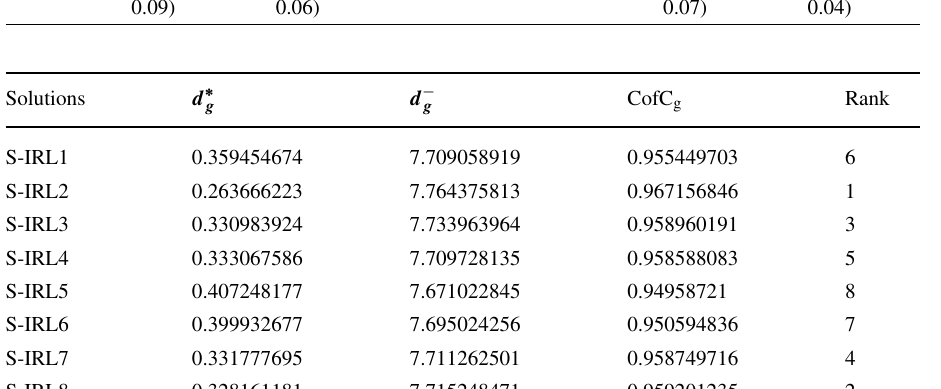
Table 13 Ranking of the solutions based on closeness coefficient (CofC g